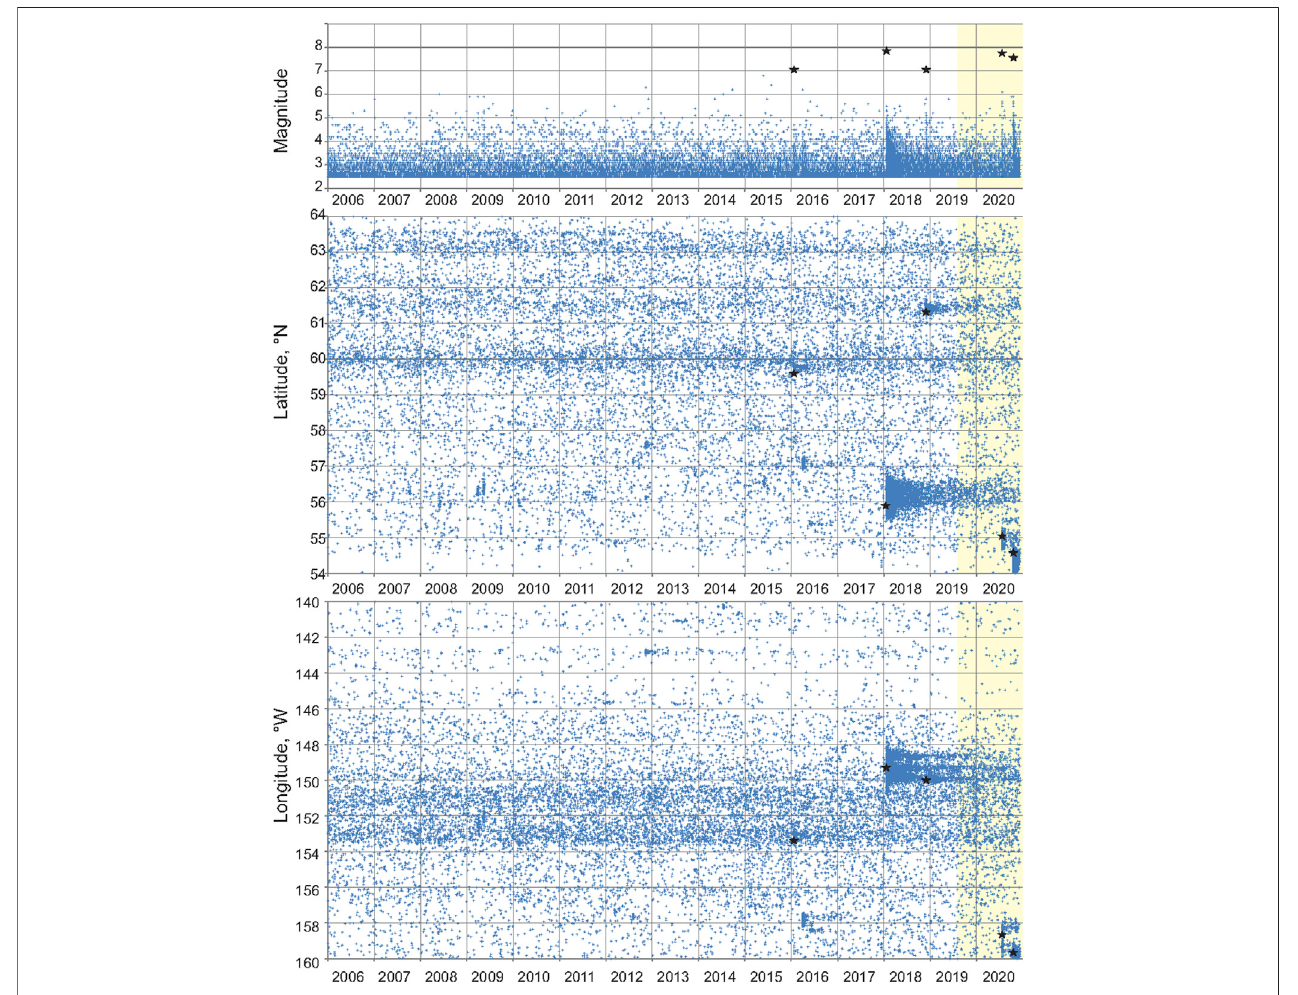
FIGURE 3 | Magnitude – latitude – longitude vs. time distribution of earthquakes in Southern Alaska, 2006 – 2020. The 4-D display of seismic activity shows the variable space – time intensity of earthquake energy release in the region, in particular, the irregular shapes of aftershock clusters including those of the three major earthquakes (black stars).